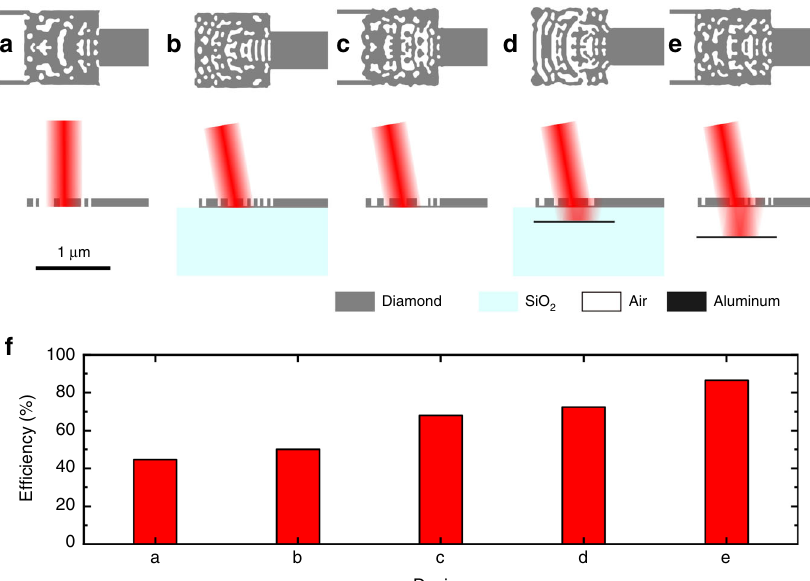
Fig. 5 Designs for high-ef fi ciency vertical couplers. a Vertically symmetric coupler suspended in air. Vertically asymmetric couplers employing partial etch with tilted incident laser beam (10°): vertical coupler b on SiO 2 , c suspended in air, d on SiO 2 with aluminum back-re fl ector, and e suspended in air with aluminum back-re fl ector. f Simulated ef fi ciencies of the devices shown in a – e : 44.7, 51.0, 67.9, 72.4, and